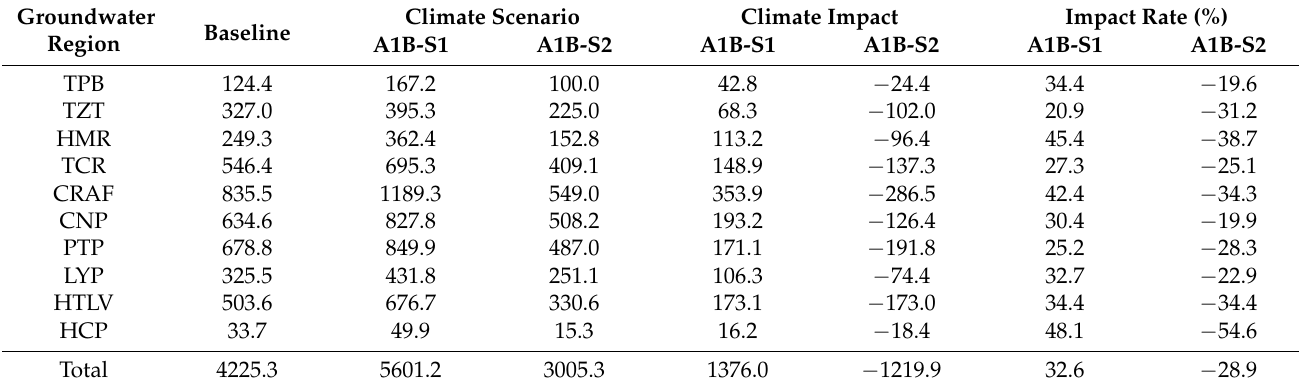
Table 9. Impact analysis of groundwater recharge under the effects of climate change in nine groundwater